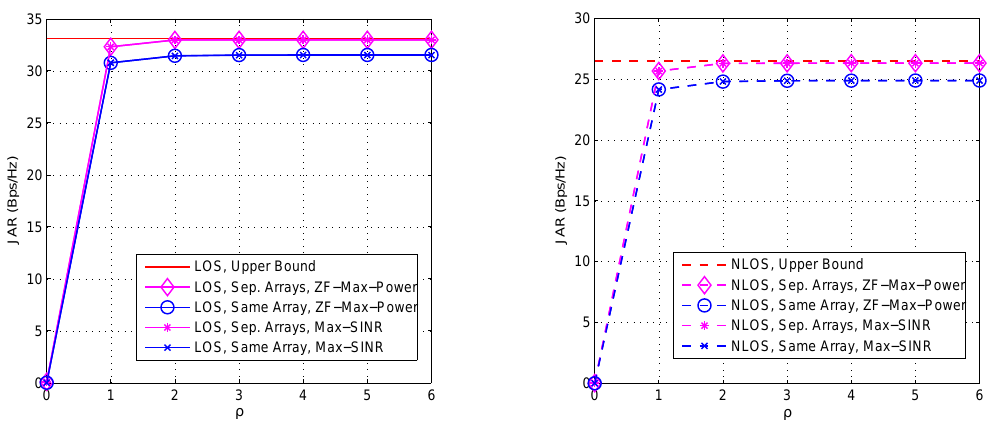
Figure 3. JAR and convergence performances of ZF-Max-Power with random initial transmit AWVs ( Left : LOS channel, Right : NLOS channel). ε 11 = ε 22 = 40 dB. For LOS channel, ε 12 = ε 21 = 20 dB, while for NLOS channel, ε 12 = ε 21 = 10 dB. For the case of separate arrays, d / λ = 1 and ω = π /6 rad, while for the case of sharing the same array, d / λ = 0 and ω = 0 rad.